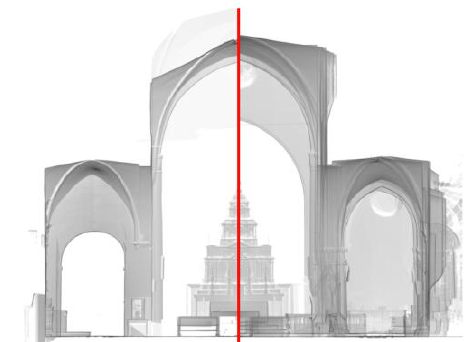
Figure 2. Digital image of a vertical section extracted using PointCab